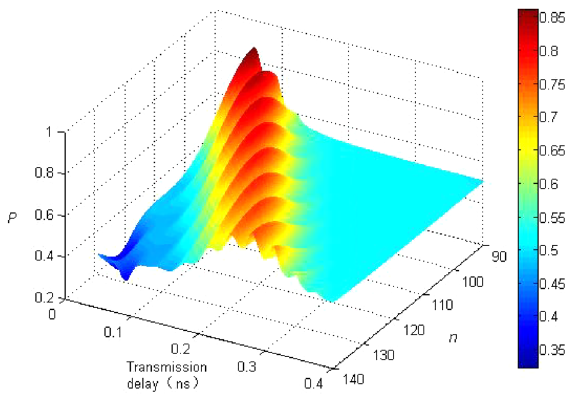
Figure 3. The simulation results of clock synchronization method when taking the impact of decoherence factors into